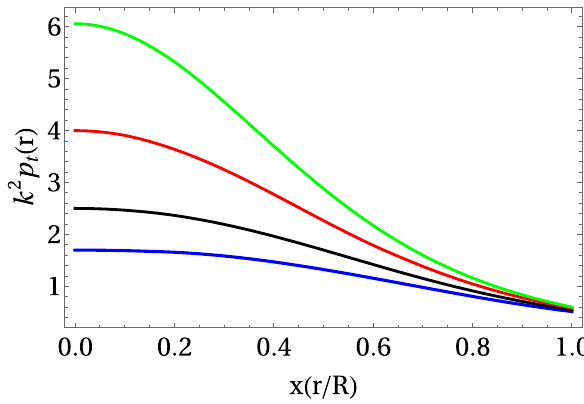
Fig. 11 Tangential pressure for Model II for compact factors: 0.38 (blue line), 0.39 (black line), 0.40 (red line) and 0.407 (green line)